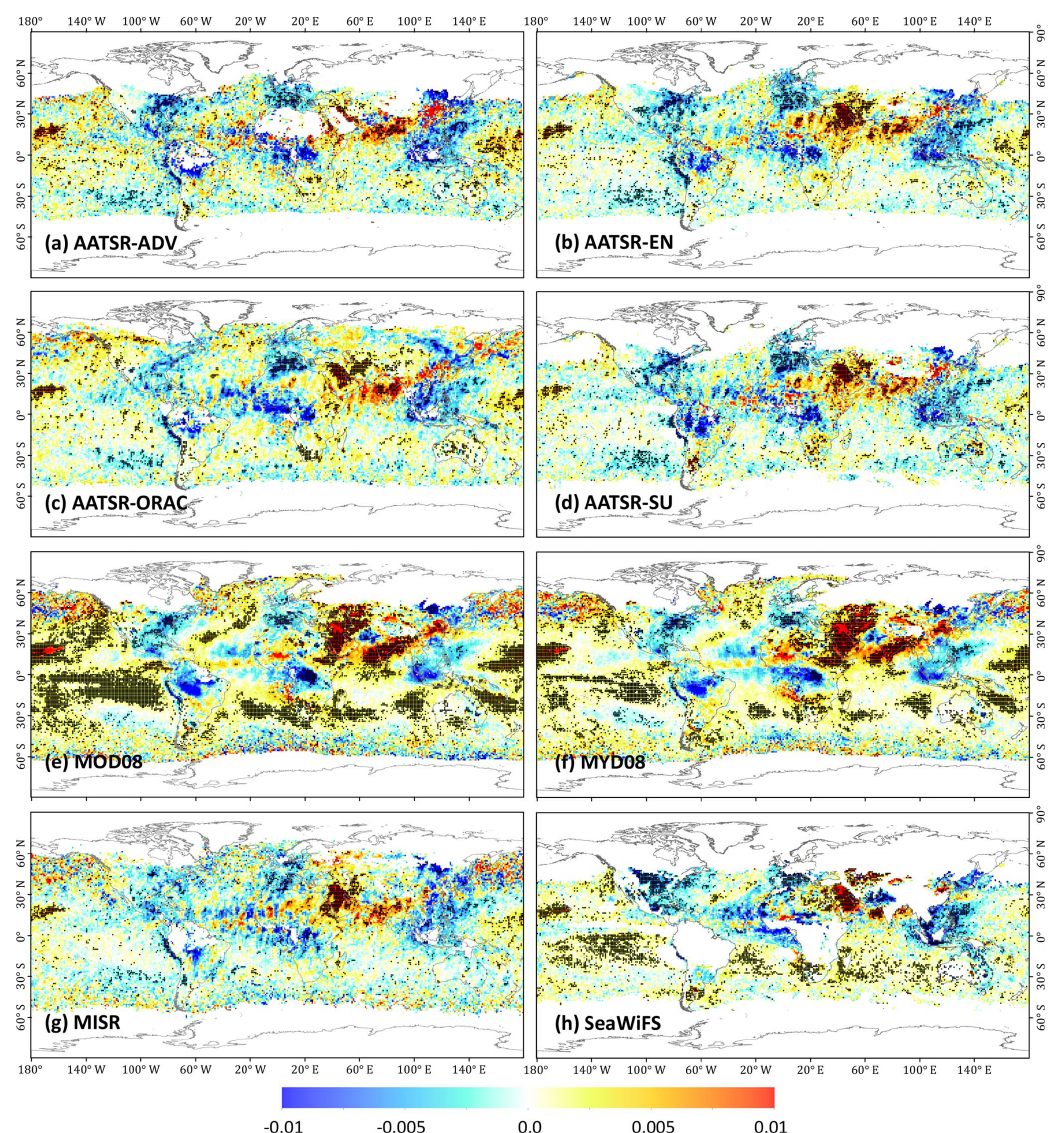
Figure 14. Linear trend based on deseasonalized monthly AOD S anomalies from 2003 to 2010. Units are AODyr − 1 . Black dots indicate a significant trend at the 95% confidence level ( p < 0 .